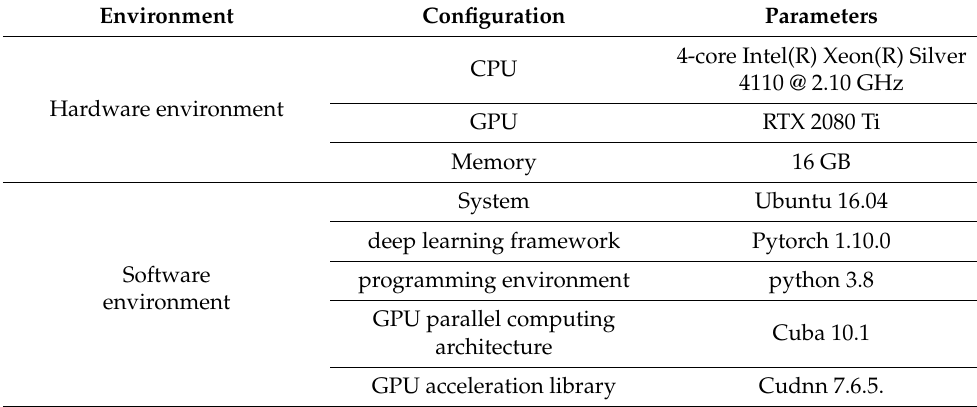
Table 1. Test environment configuration.